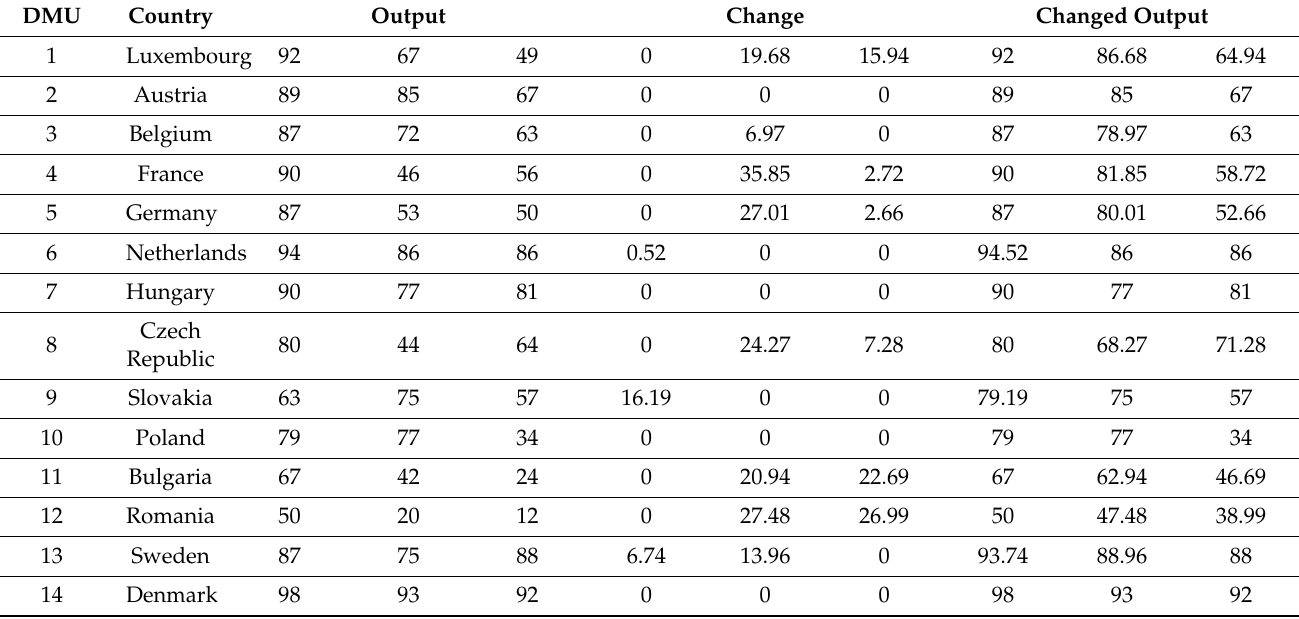
Table 13. Changing outputs to achieve